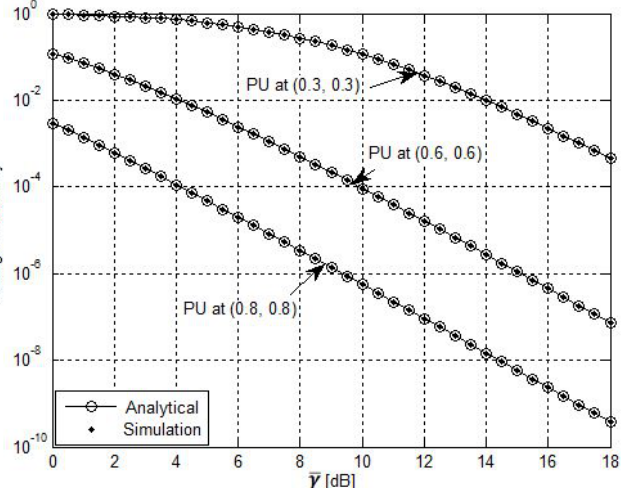
Figure 4. Impact of primary user location on the system performance, ( m sp = 1, m sk = m kp = m kd = 2 and N =